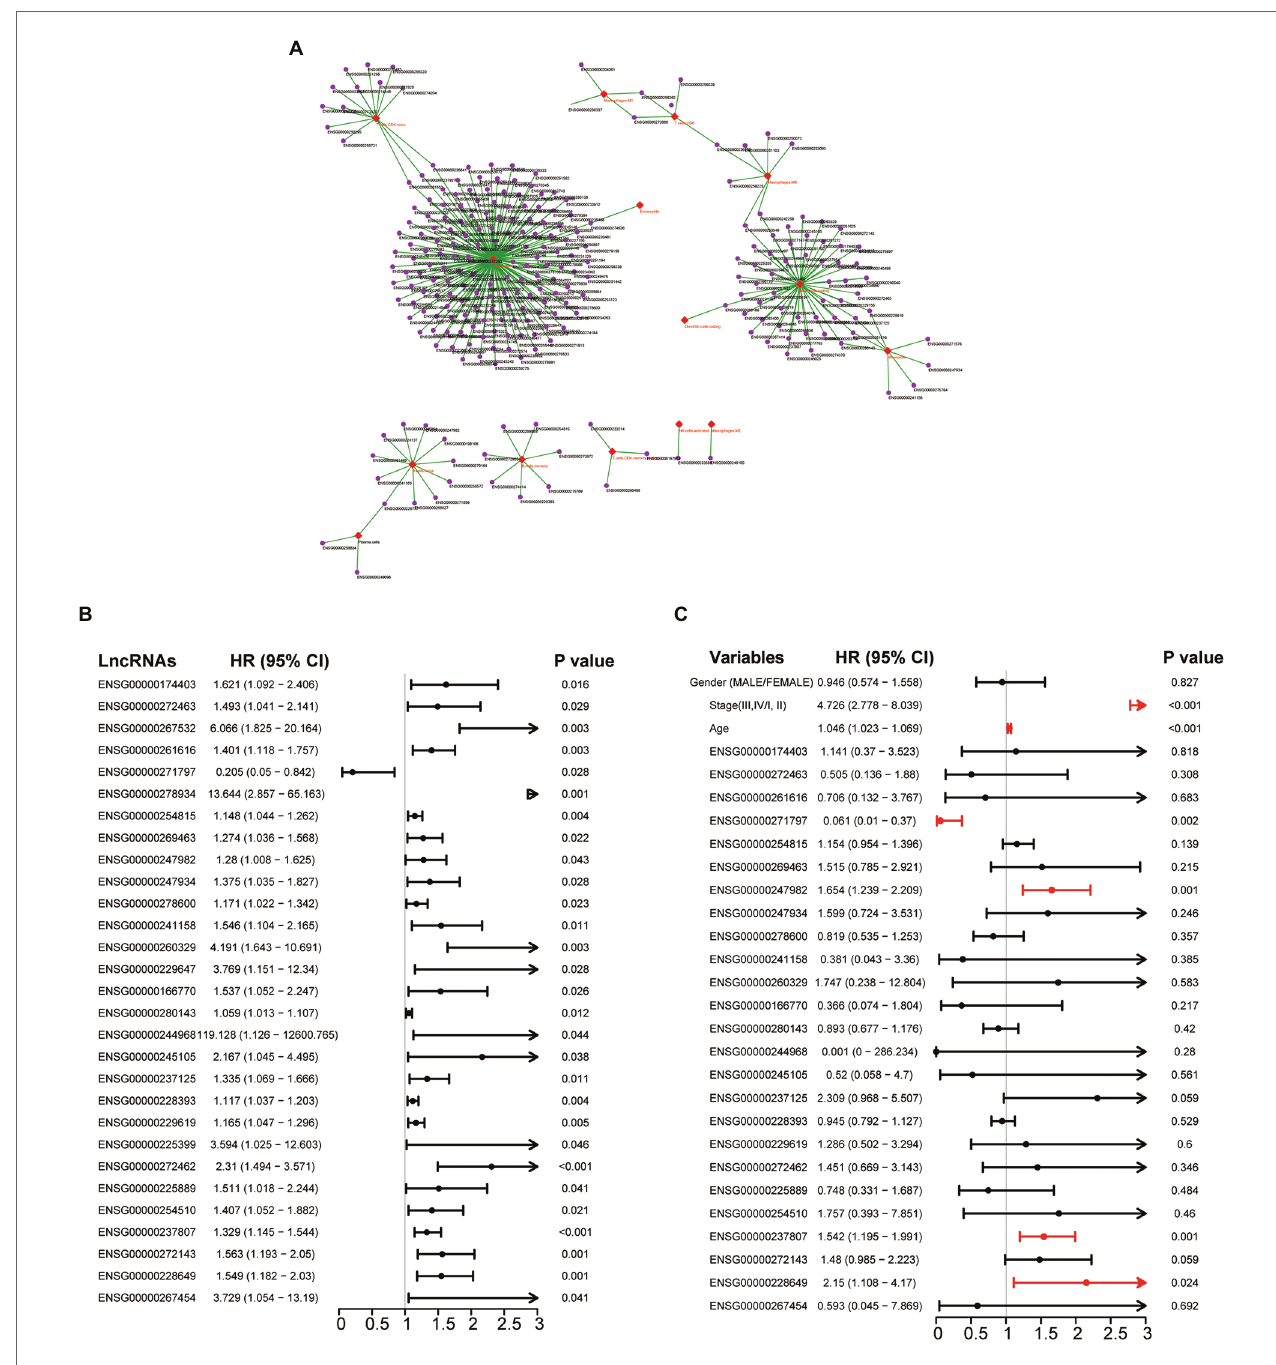
FIGURE 1 | Identification of prognostic tumor immune infiltration-associated long non-coding RNAs (lncRNAs) in colon cancer. (A) Network representing the association between lncRNA and infiltrating immune cells using the Cytoscape software. (B) Forest plot representing hazard ratio (HR) and 95% CI of each prognostic lncRNAs derived from Univariate analyses with Cox proportional hazards regression. (C) Forest plot representing HR and 95% CI of each prognostic lncRNAs derived from multivariate analyses with Cox proportional hazards